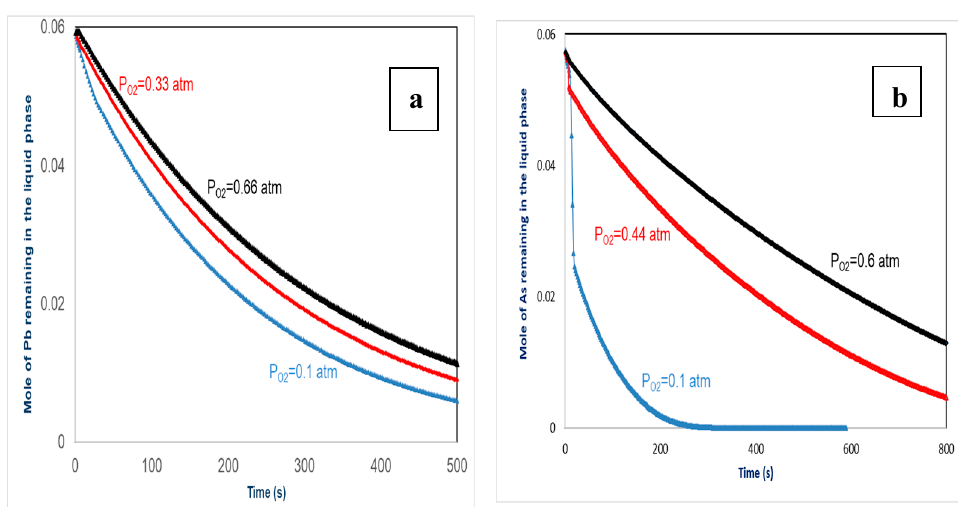
Figure 8. Influence of partial pressure of oxygen on the volatility of: ( a ) Pb, ( b ) As.